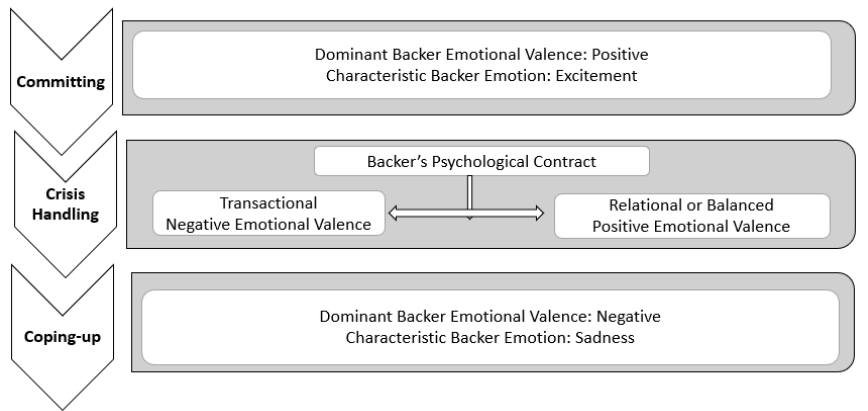
Figure 4. Framework depicting three progressive stages of backers’ behavior and emotional valence in their interactions with campaign creators in failed RBC campaigns.